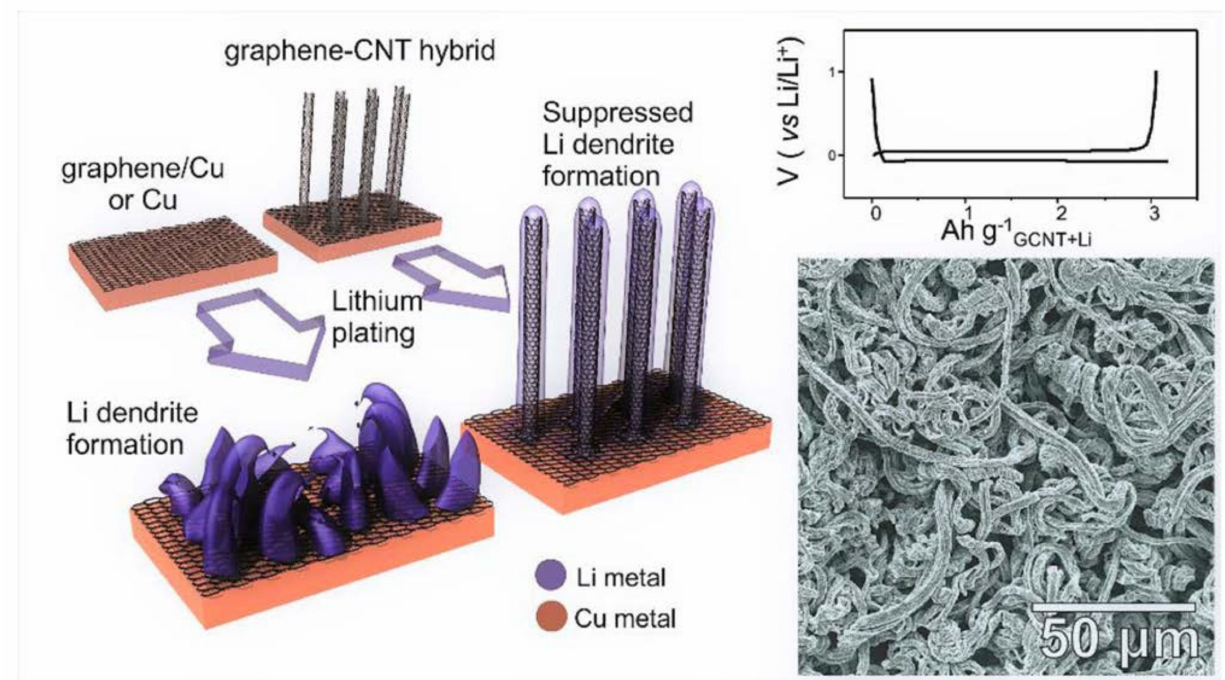
Figure 7. ( Left ) Schematic of Li deposited on graphene grown on Cu. Schematic of GCNT–Li formation. ( Right above ) Voltage vs. time of lithiation and delithiation processes of GCNT–Li. ( Right below ) SEM images of delithiated GCNT–Li (0.7 mAh cm − 2 at 2 mA cm − 2 ) after 250 cycles. (Reproduced with permission from ref